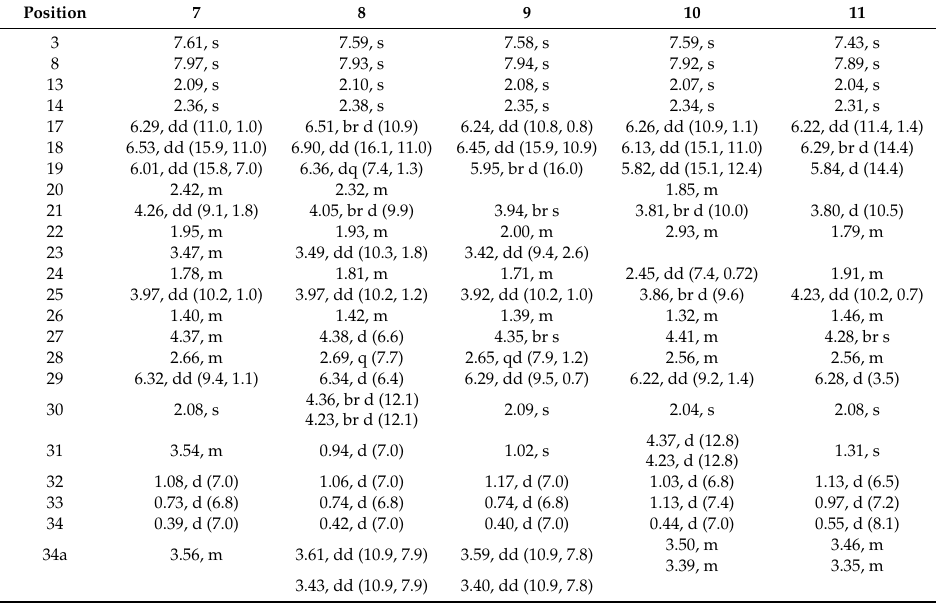
Table 3. 1 H NMR (400 MHz) Spectroscopic Data of Compounds 7 – 11 ( δ H , in MeOD, J in Hz)